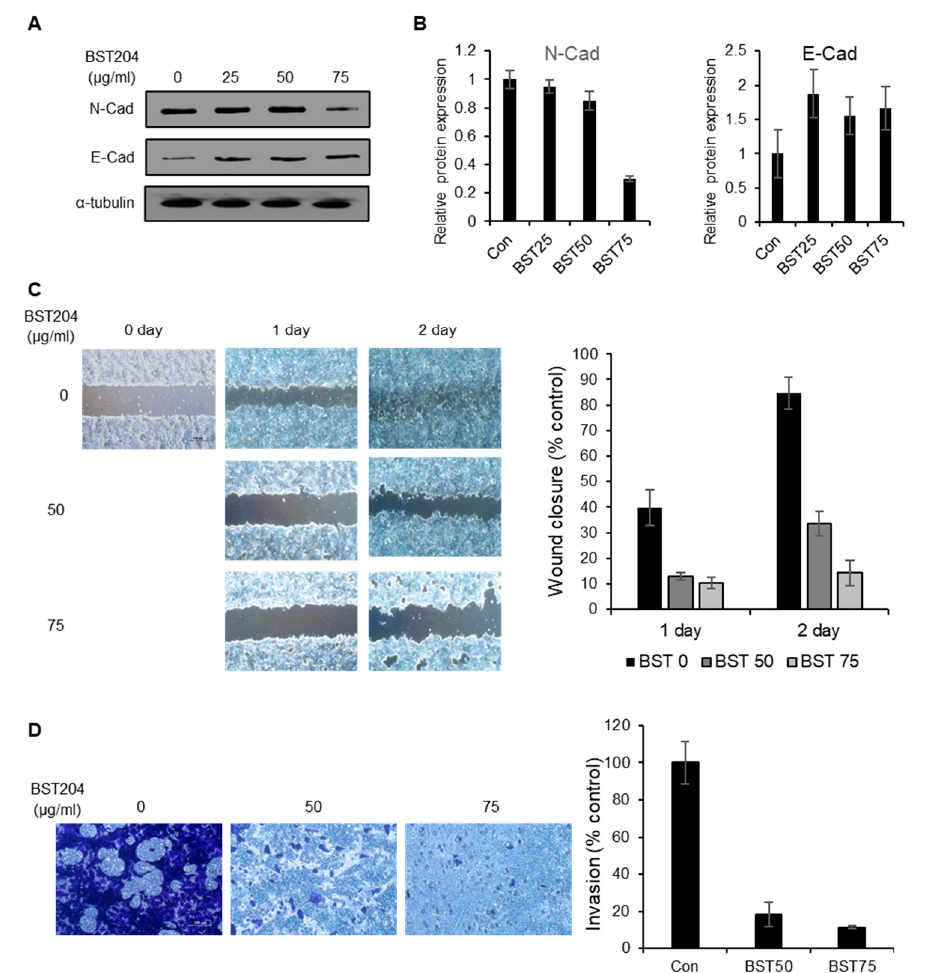
Figure 4. Effects of BST204 on EC cell migration and invasion. ( A ) Expression of N-cadherin and E-cadherin was analyzed by immunoblotting. Alpha-tubulin was used as an internal control. ( B ) Relative expression of each protein was analyzed. ( C ) The effects of BST204 on cell migration were evaluated by a wound healing assay. A wound was created by scratching the cell monolayer using a pipette tip. Cells were incubated with BST204 at the designated concentration for 2 days. Wound healing was captured using an Olympus IX70 microscope. (Scale bar: 100 µ m) The quantification of wound closure (% control) is exhibited. ( D ) For the invasion assay, NCCIT cells were seeded (5 × 10 4 cells / well) in a Matrigel-coated 24-well plate in the presence or absence of BST204 for 24 h. The invading cells were stained with 0.5% crystal violet and photographed using an Olympus IX20 microscope. (Scale bar: 100 µ m). The quantification of the invasion (% control) is